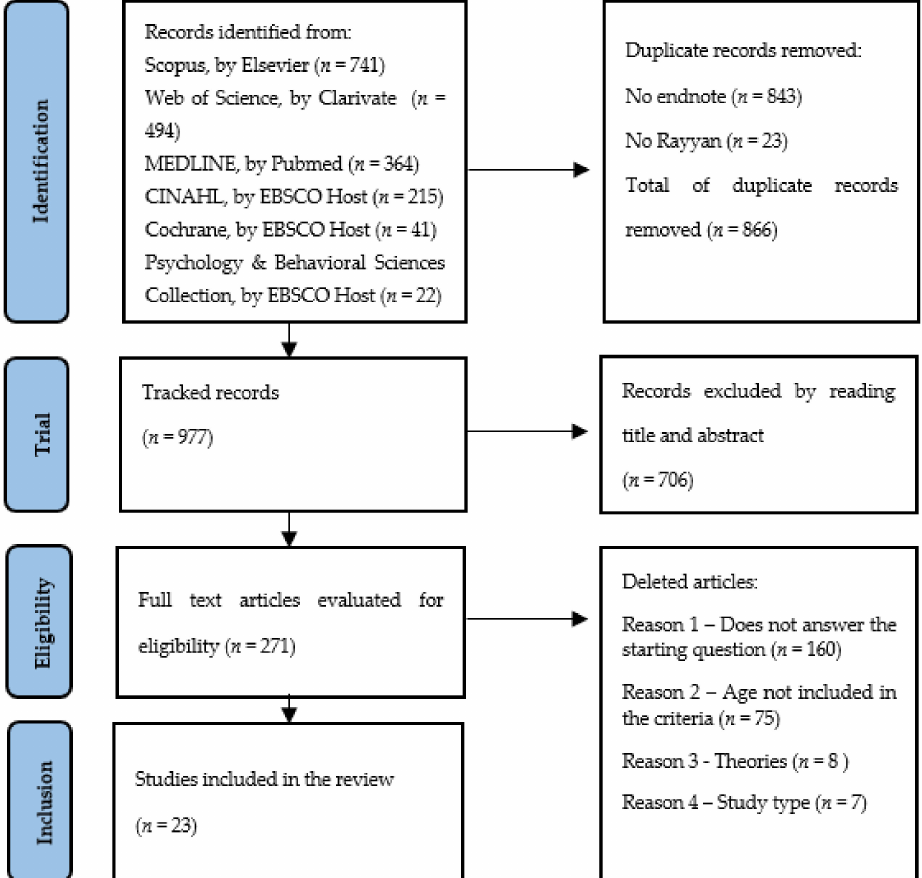
Figure 1. PRISMA of study selection and inclusion process